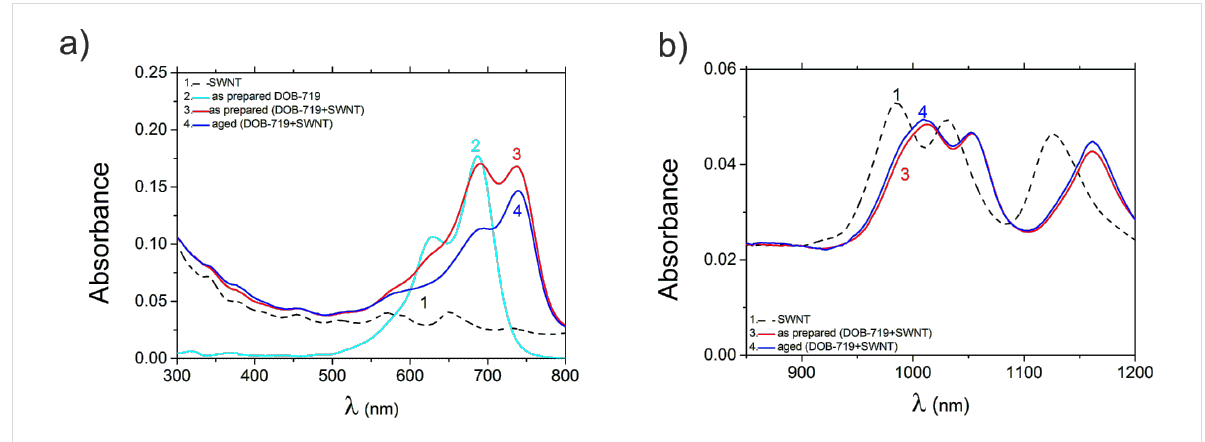
Figure 3: Absorption spectra in (a) the visible and (b) the NIR range for dispersions of SWNT (1), aqueous solutions of neat DOB-719 (2), as-pre- pared mixtures of DOB-719 with SWNT (3), and aged mixtures of DOB-719 with SWNT (4). The concentration of DOB-719 is 0.001 mg/mL.